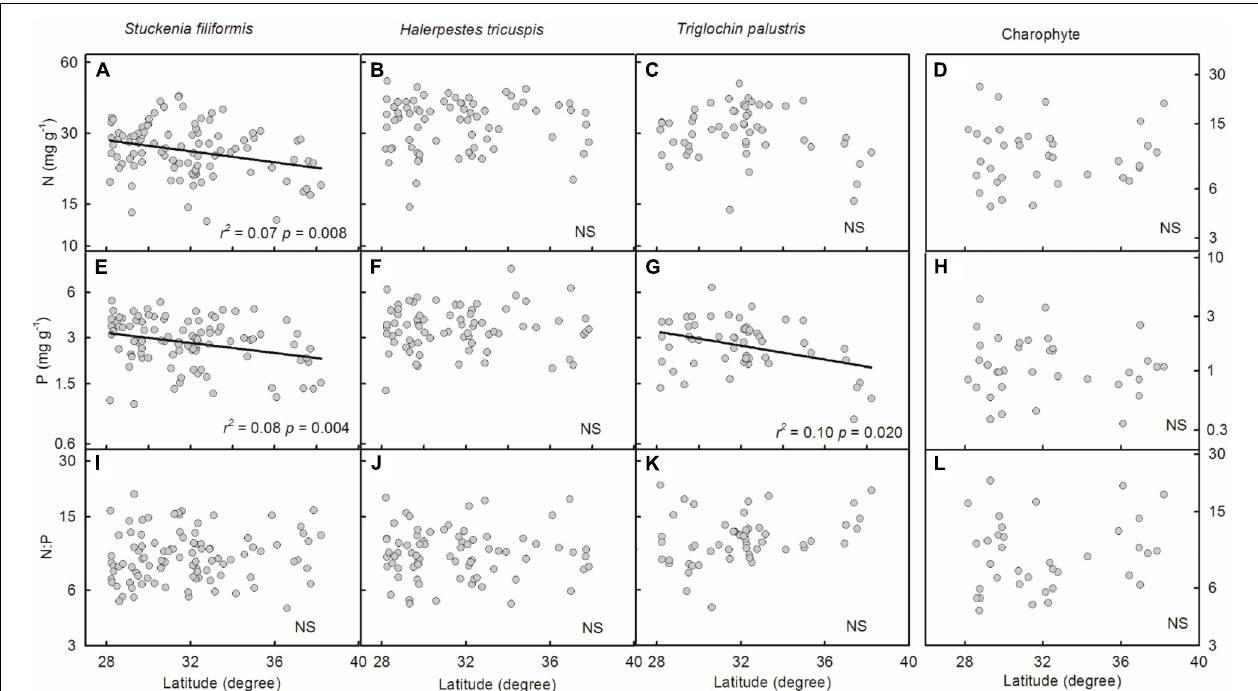
FIGURE 4 | Trends of plant N and P concentrations and N:P ratios along latitudinal gradients (A–L) . The p -value in each panel was the original one of each test if it was smaller than the corrected one obtained by Holm’s Sequential Bonferroni Procedure. If not, the test was non-significant (NS).